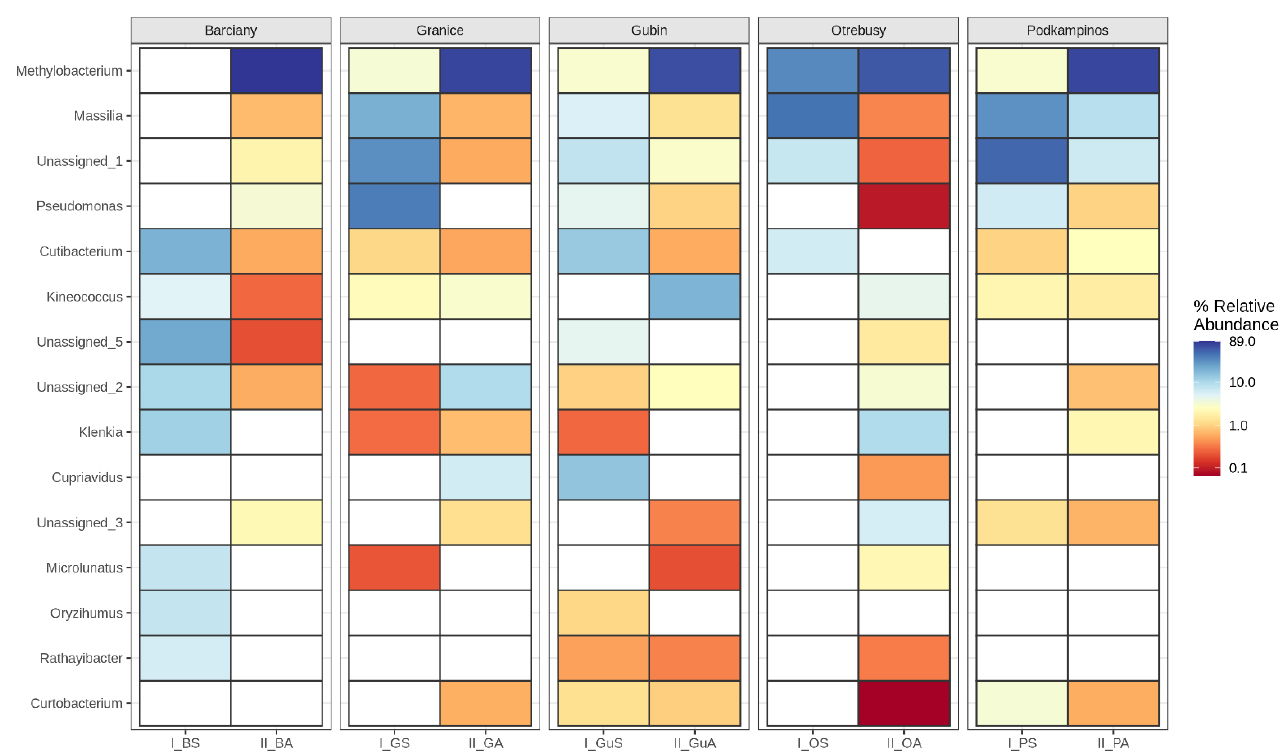
Figure 4. Heatmap showing the relative abundances of bacterial communities at the genus level. Using Venn diagrams, information on the unique and shared bacterial genera among different localities was obtained (Figure 5). The composition of the core endomicrobiome of leaves from Paulownia consisted of nine bacterial genera, namely Methylobacterium , Klenkia , Pseudomonas , Massilia , Cutibacterium , Kineococcus , Unassigned_1, Unassigned_2 and Unassigned_3. The largest number of unique genera (32) was found for the samples from Gubin, sharing the most bacterial genera with the samples from Otrebusy (13). The leaf microbiomes from Otrebusy had 16 unique bacterial genera, whereas those from Granice had 3 unique bacterial genera, of which 3 were shared with the samples from Gubin. In contrast, the bacterial communities of the leaves from Barciany had no unique bacterial genera.